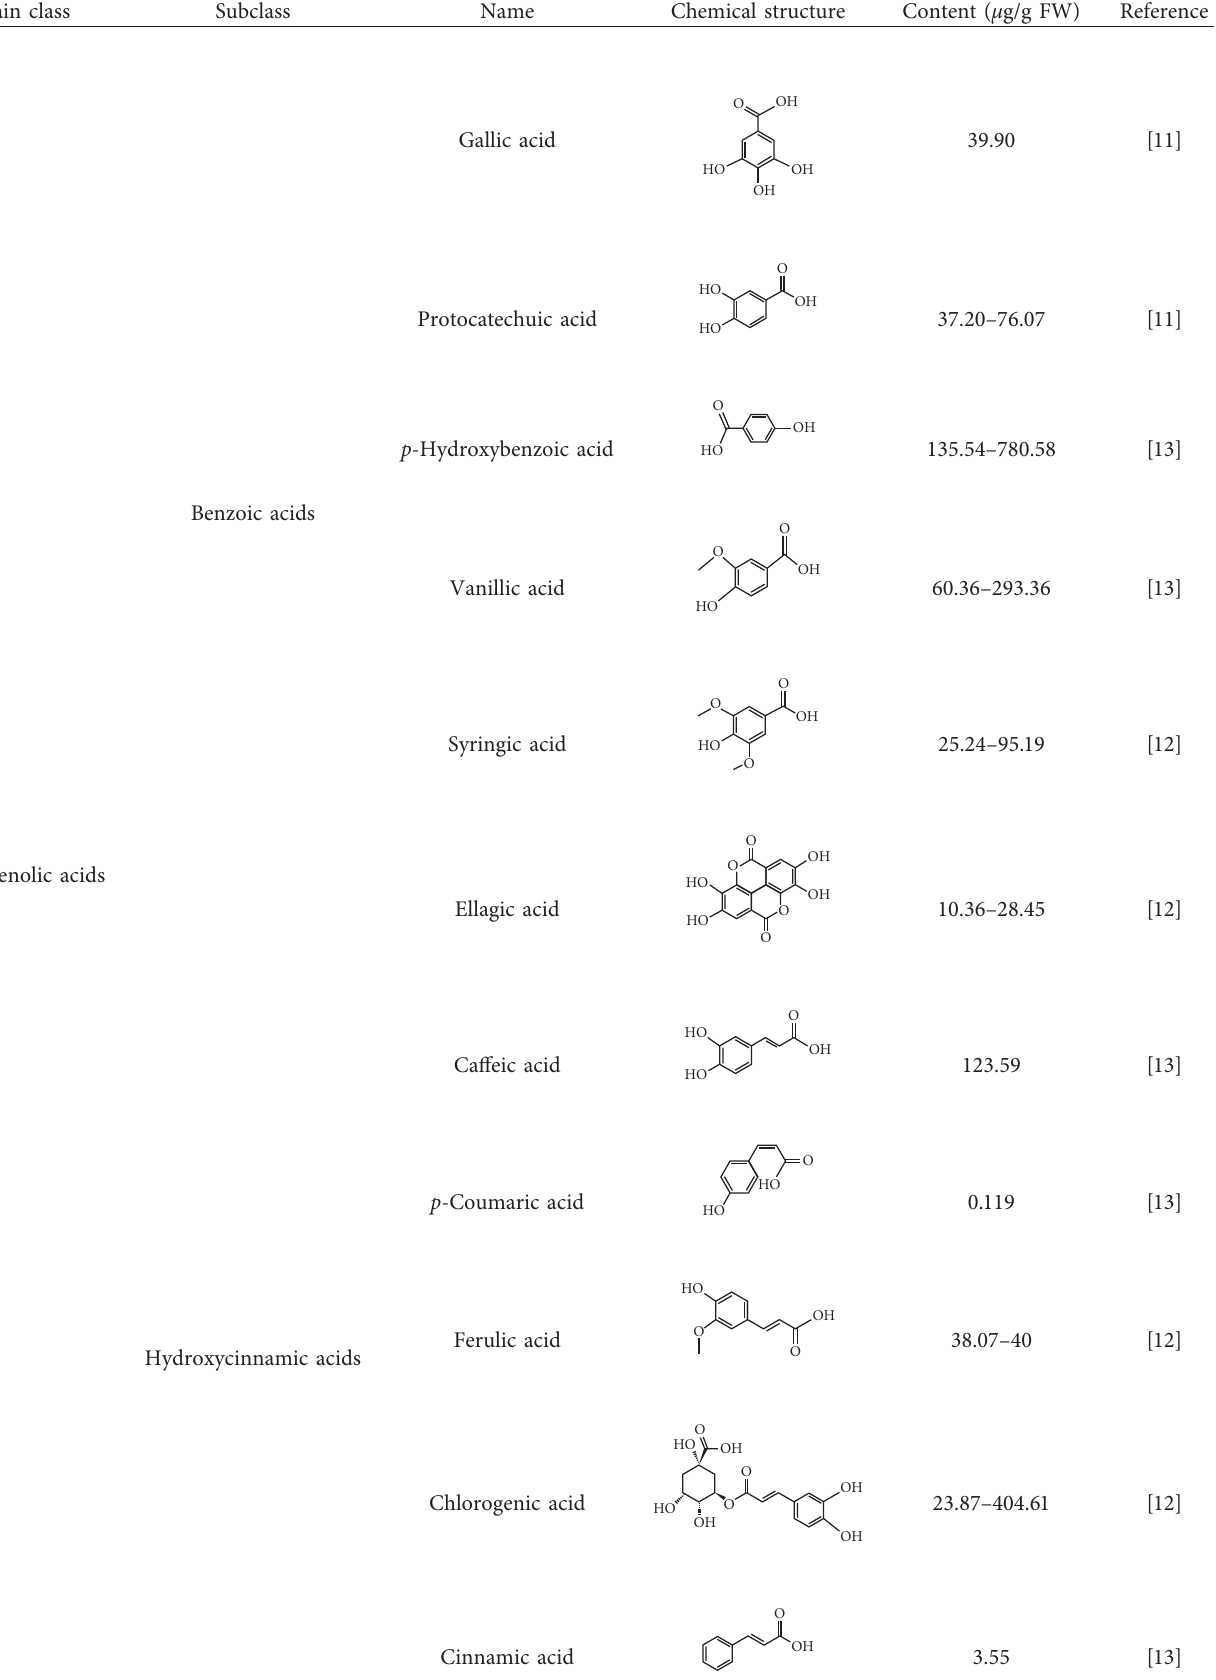
Table 2: Individual polyphenols in Malus prunifolia